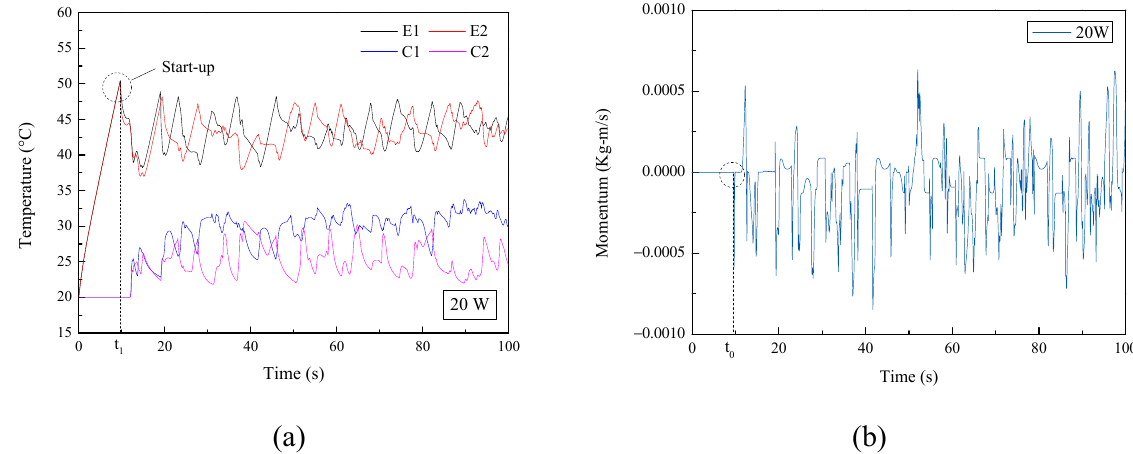
Figure 5. Operation characteristics of the PHP at 20 W (La = 180 mm): ( a ) temperature fluctuation of the evaporation section and the condensation section; ( b ) momentum of the liquid slugs.